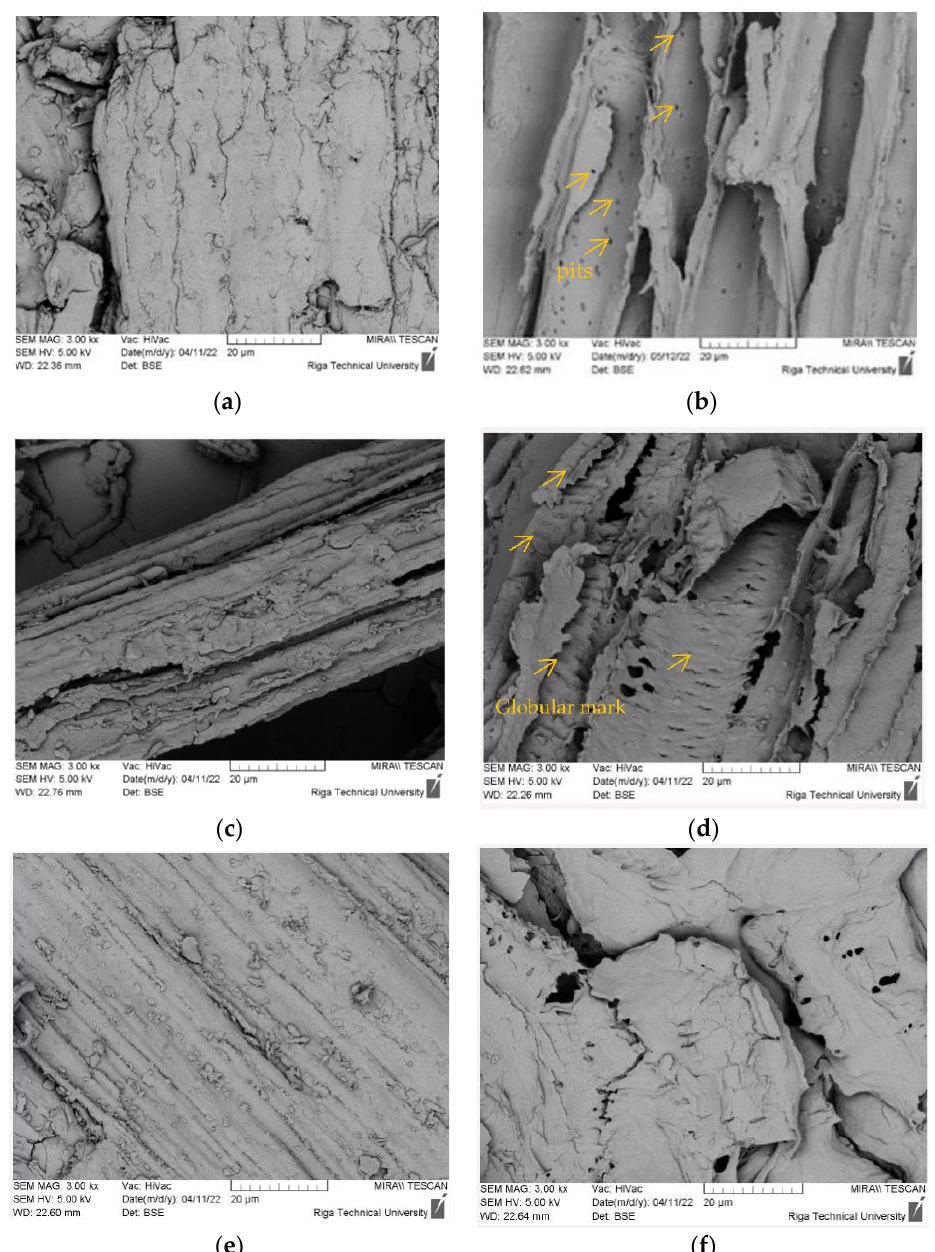
Figure 6. SEM surface images of ( a , c , e ) untreated and ( b , d , f ) treated ( a , b ) RS, ( c , d ) SCS, and ( e ,f) BS fibers at the suggested treatment conditions (i.e., with 2% NaOH solution for 30 min for SCS and RS fibers, and with 5% NaOH solution for 60 min for BS fibers).